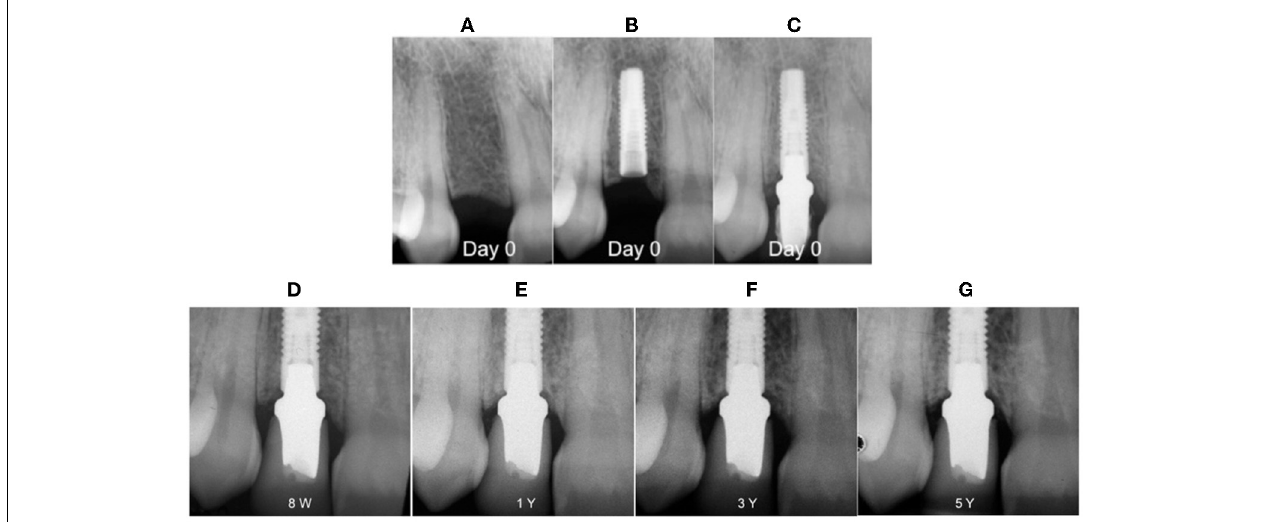
FIGURE 3 | Digital intra-oral radiographs of implants placed in healed ridge. (A) Pre-operative situation; (B) implant placement; (C) abutment placement; (D) 8 weeks after definitive crown cementation; (E) after 1 year; (F) after 3 years; (G) after 5